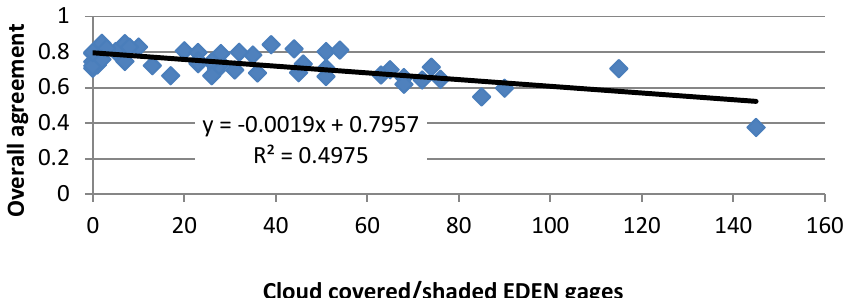
Figure 9. Scene-level overall agreement versus the number of gages obscured by clouds as assessed by sampling the cloud mask associated with each date. Although the goal is to detect inundation for all cloud/cloud shadow free pixels, overall model performance is degraded by the presence of a cloudy